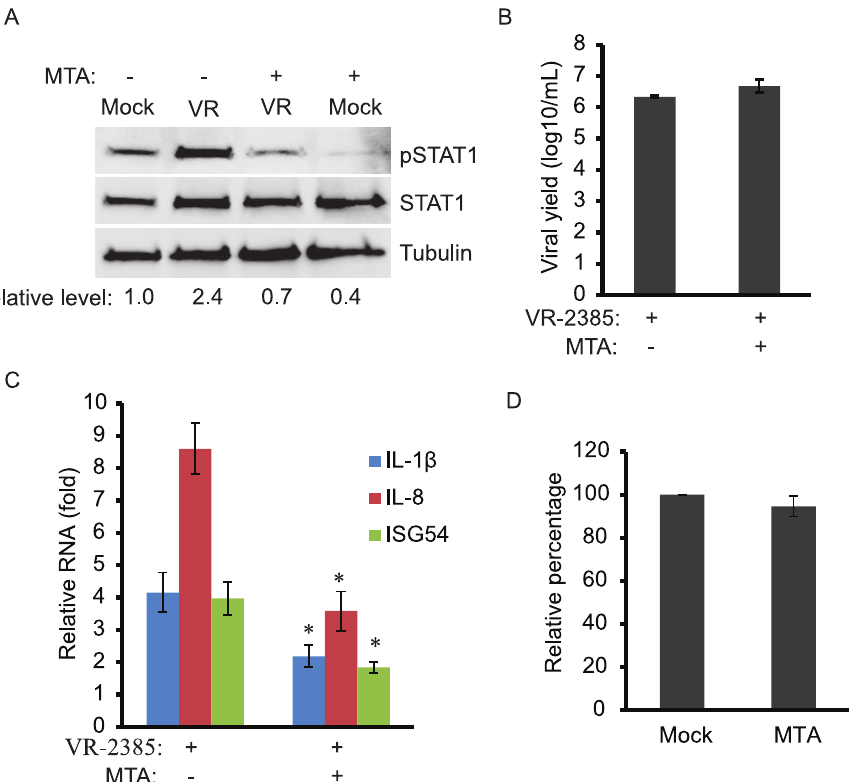
Figure 5. Inhibition of PRRSV-mediated STAT1 phosphorylation by methylthioadenosine (MTA). A. MTA treatment leads to blockage of VR-2385-induced STAT1 phosphorylation. MARC-145 cells were infected with VR-2385 and treated with MTA. The cells were harvested at 24 hpi for Western blotting with antibodies against pSTAT1-S727, STAT1, and tubulin. Relative levels of pSTAT1 in comparison to the mock-treated and uninfected cells are shown as folds below the images. B. PRRSV yield remains stable in the presence of MTA. The virus samples were titrated and the result is shown as log10 TCID50/ml. C. MTA treatment reduces PRRSV-induced expression of proinflammatory cytokine genes. MARC-145 cells were infected with VR-2385 and treated with MTA. The cells were harvested at 48 hpi for RNA isolation and RT-qPCR. ‘‘*’’ indicates significant differences ( P , 0.05) between MTA-treated and mock-treated cells. D. Cell viability assay of MTA-treated MARC-145 cells. The cells were subjected for the assay 24 h after treatment. Relative percentages in comparison with mock-treated cells are